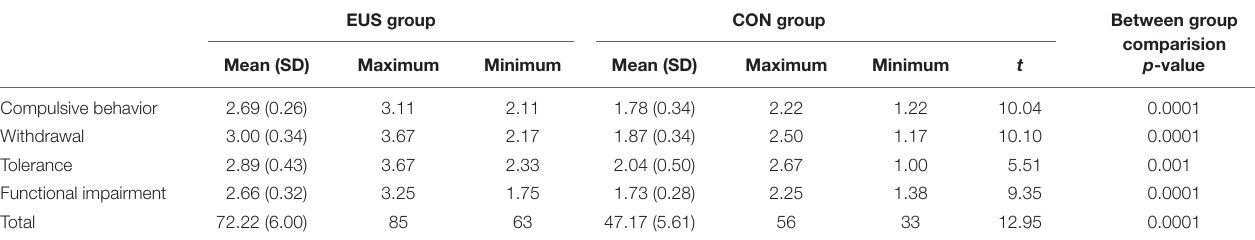
TABLE 1 | The SPAI score between groups. EUS group CON group Between group